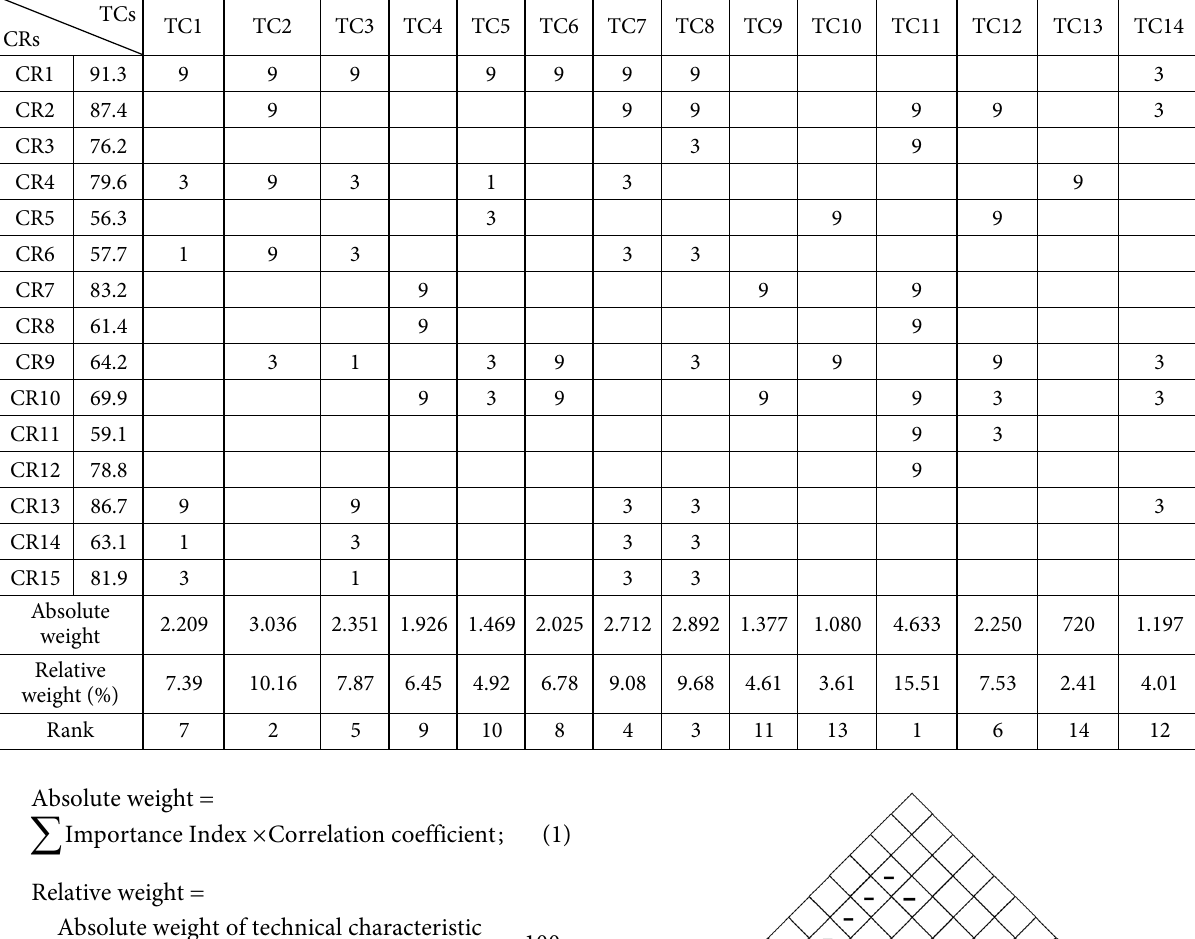
Table 5. A calculation matrix for absolute and relative weights between TCs and CRs